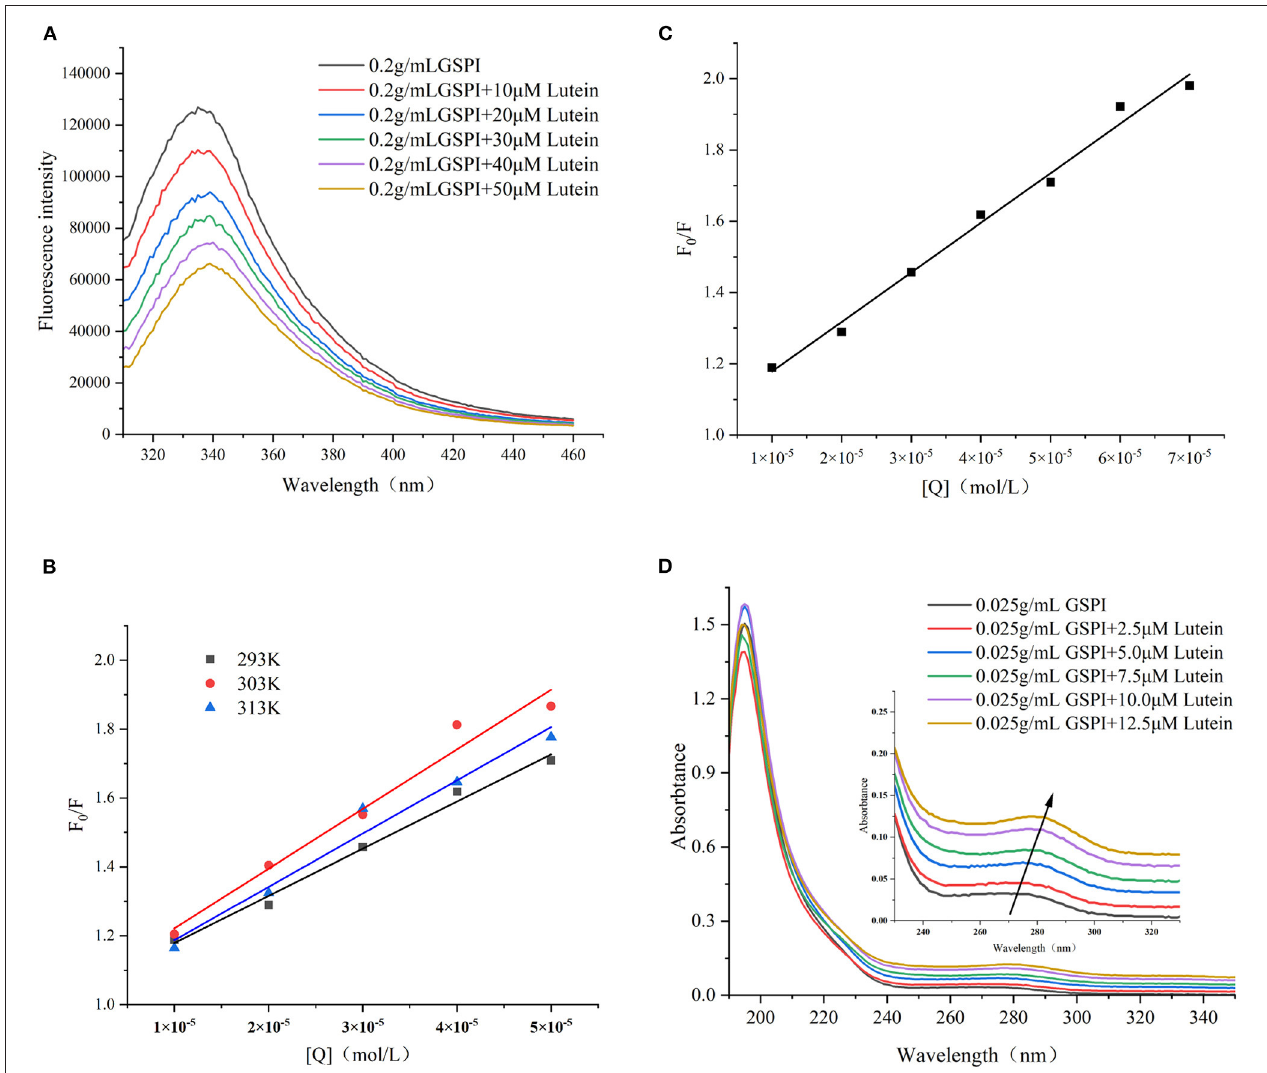
FIGURE 3 | (A) Fluorescence spectra of GSPI (0.2 mg/ml) with different concentrations of lutein (0–50 µ M), T = 293K, pH = 7.0, and λ ex = 280nm. (B) The linear Stern–Volmer plot for lutein binding to GSPI at 293, 303, and 313K. (C) The Stern–Volmer plot for lutein binding to GSPI with lutein (0–70 µ M) at 293K. (D) UV–Vis spectra of GSPI (0.2 mg/L) with different concentrations of lutein (0–50 µ M), T = 293K, and pH = 7.0.